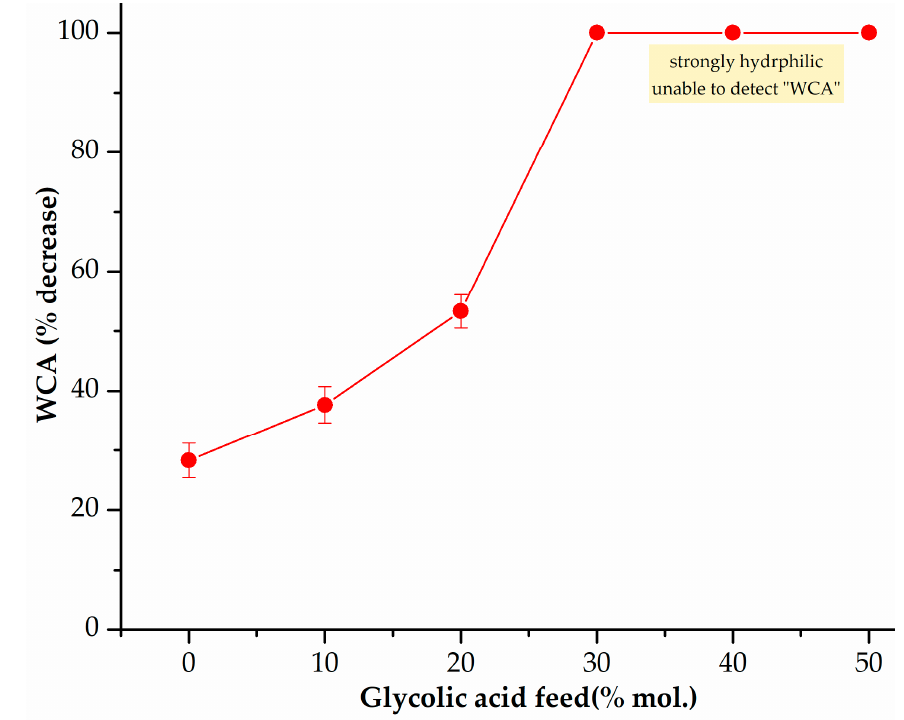
Figure 6. After 2 min of oxygen plasma treatment, the % decrease in the water contact angle (WCA). A higher percentage decrease is in the WCA of the films with higher glycolic acid contents.